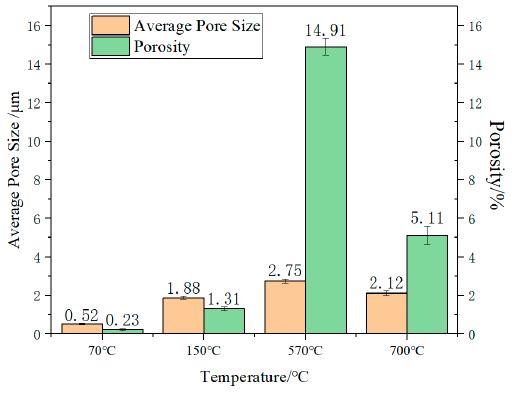
Figure 5. Average pore size and porosity at different temperatures.